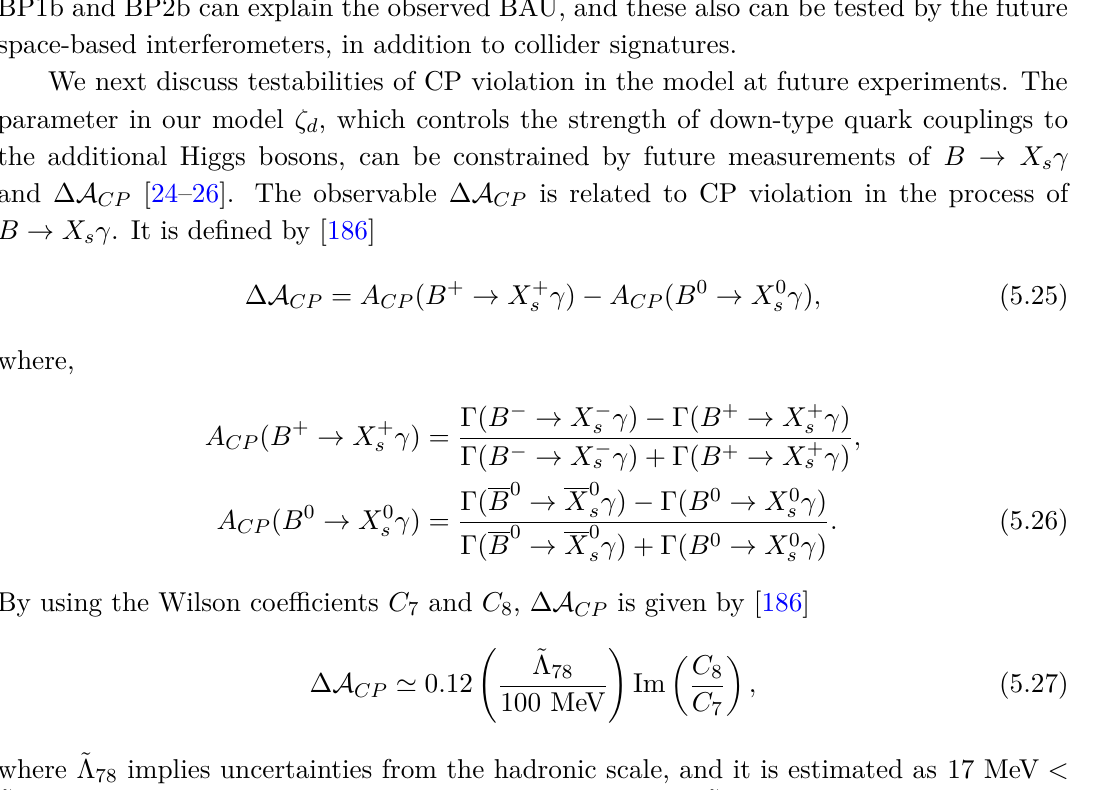
are the GW spectra at the BP1a and BP1b, respectively, while the ones at the BP2a and BP2b are shown in the right panel. The BP1b whose velocity is 0.45 reaches the sensitivity curves of DECIGO and BBO, and the BP2b only reaches the one of BBO. Therefore, the BP1b and BP2b can explain the observed BAU, and these also can be tested by the